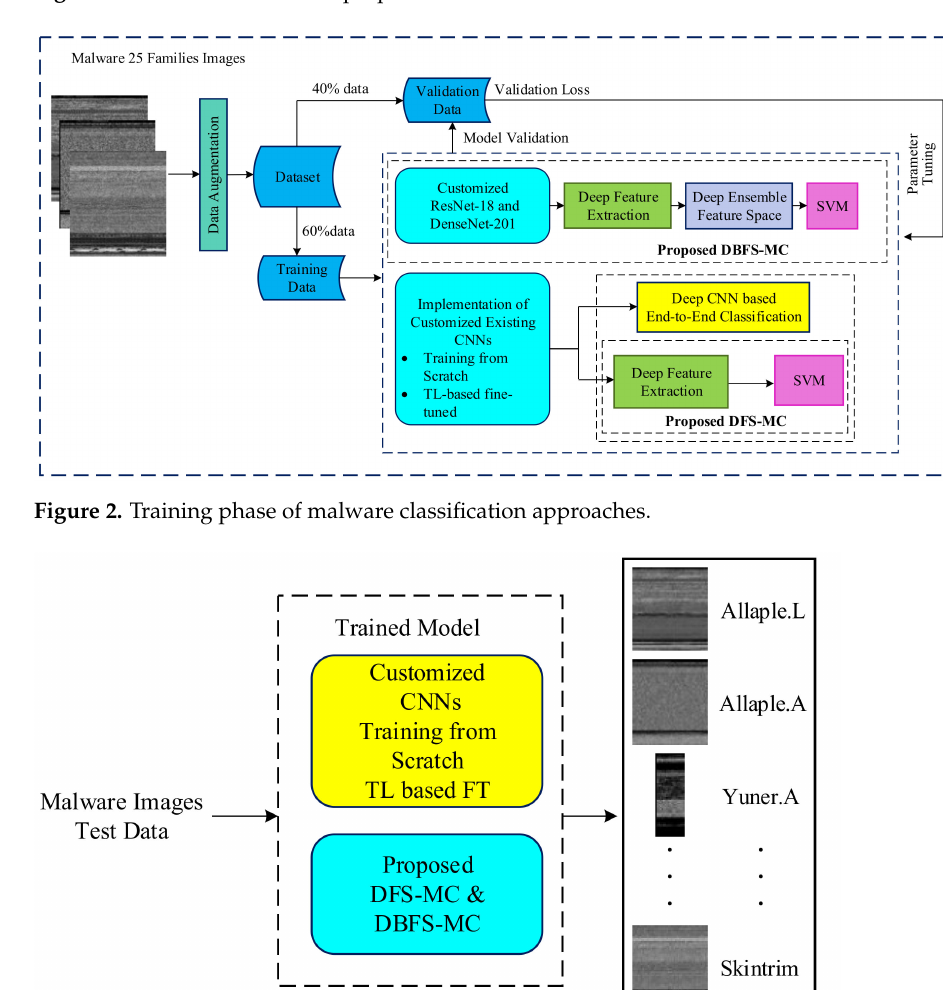
Figure 1. Brief overview of the proposed malware classification framework.